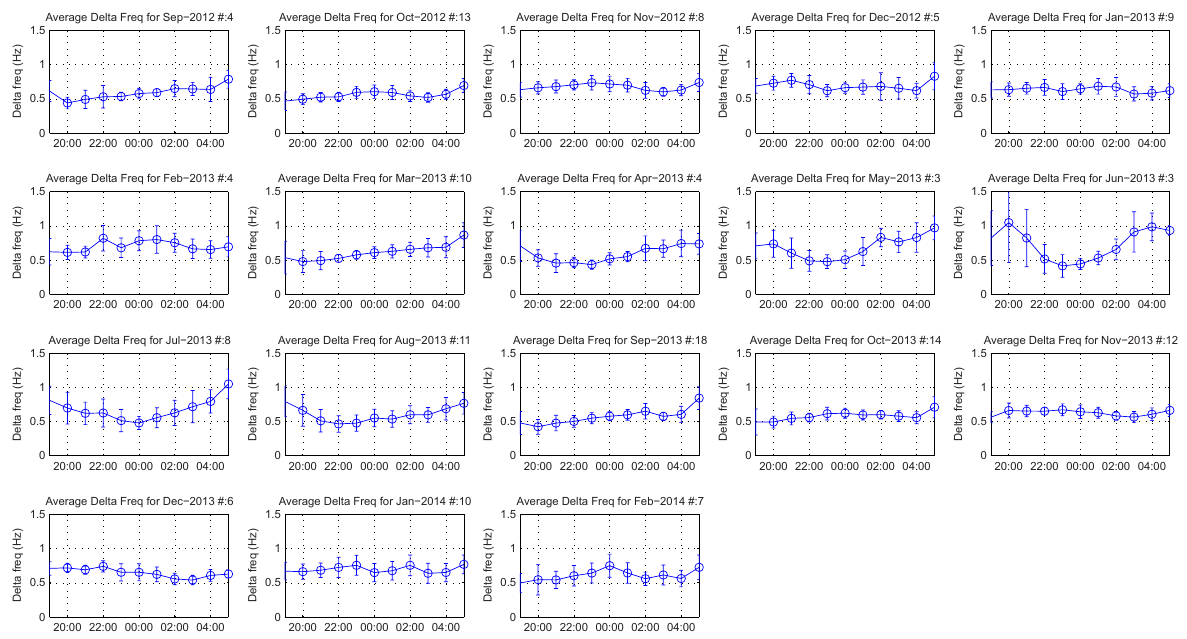
Figure 6. Plots of the hourly mean value of 1f for 152 selected “good” days in each month from September 2012 to February 2014. Error bars show 1 σ -level variation.